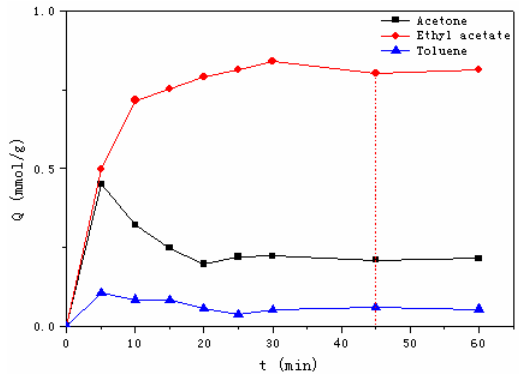
Figure 6. Competitive adsorption of acetate, ethyl acetate and toluene.